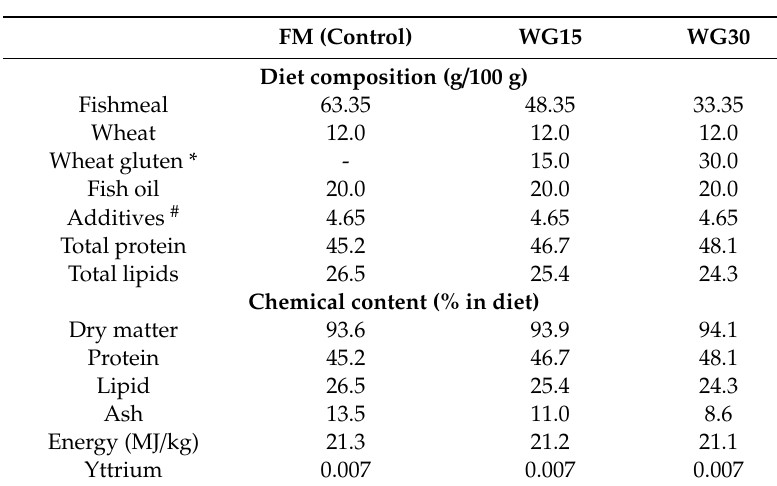
Table 1. Formulation and chemical contents of the custom-made salmon diets used in this study. The control diet contained only fishmeal (FM) as protein source, which was partly replaced by